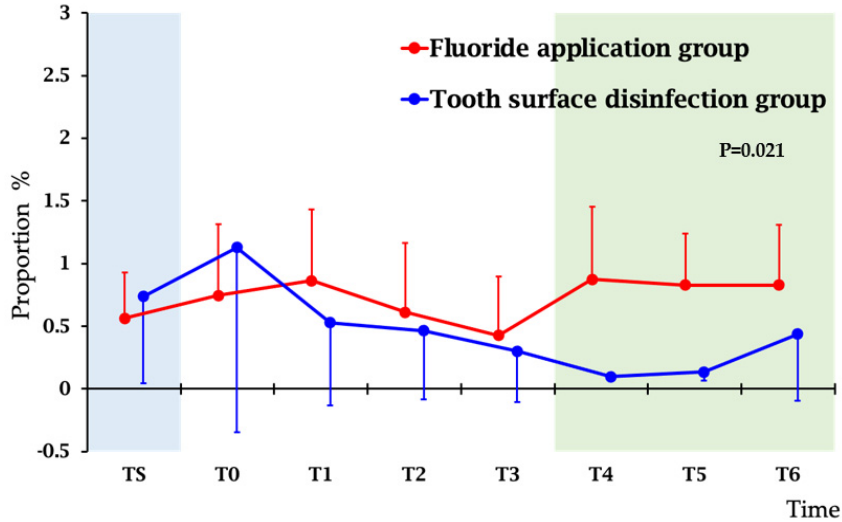
Figure 1. Changes of salivary levels of proportion of mutans streptococci in total streptococci during study periods. p -values were calculated by mixed effect model. Changes of cariogenic bacteria were all statistically significant. The results of mixed effect models were shown in Table S2. Time-points: TS, screening; T0, at the start of study (baseline); T1: after 1 month; T2: after 2 months; T3: after 3 months; T4: after 4 months; T5: after 5 months; T6: after 6 months.